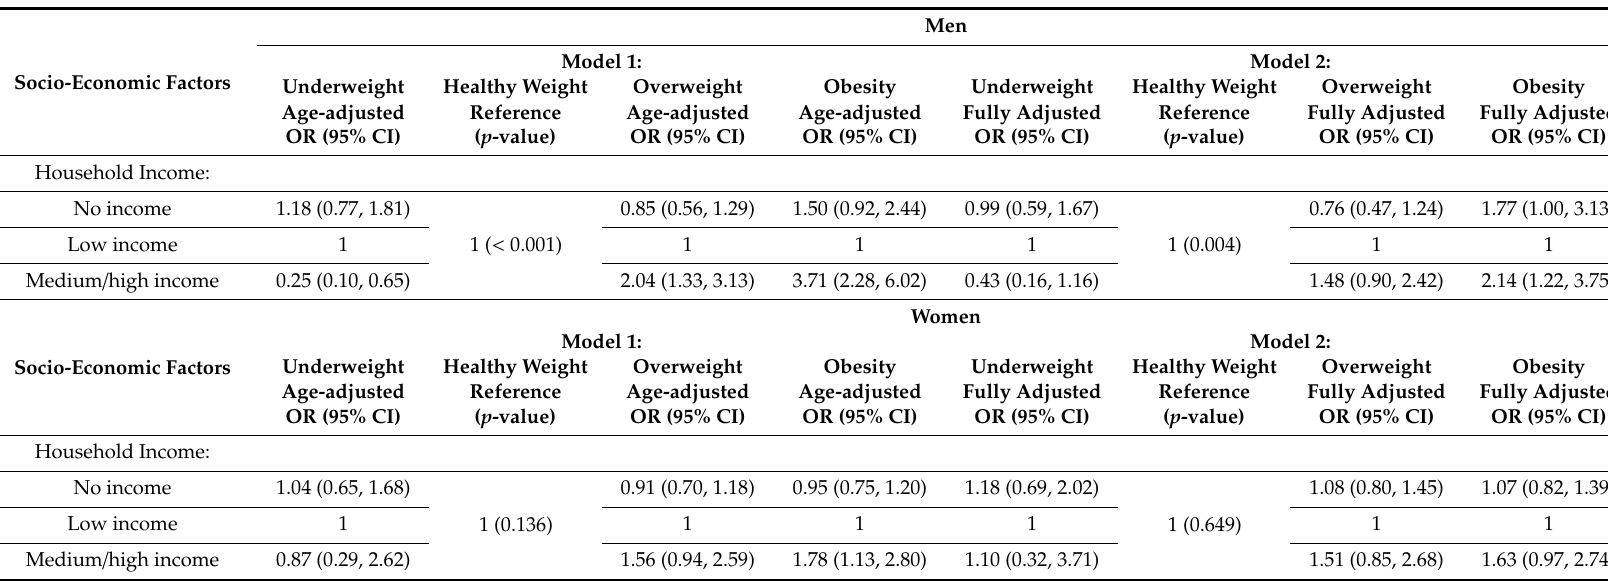
Table 6. Relative risk of underweight, overweight and obesity among 1140 men and 2218 women from the SANHANES study in 2012; by income (minimally and fully adjusted odds ratios from multinomial